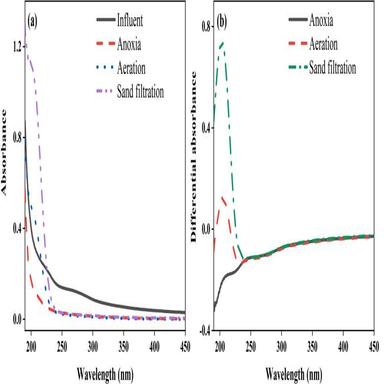
Typical (a) original and (b) differential UV spectra of different process units. Sampling date: Nov. 12th, 2020.